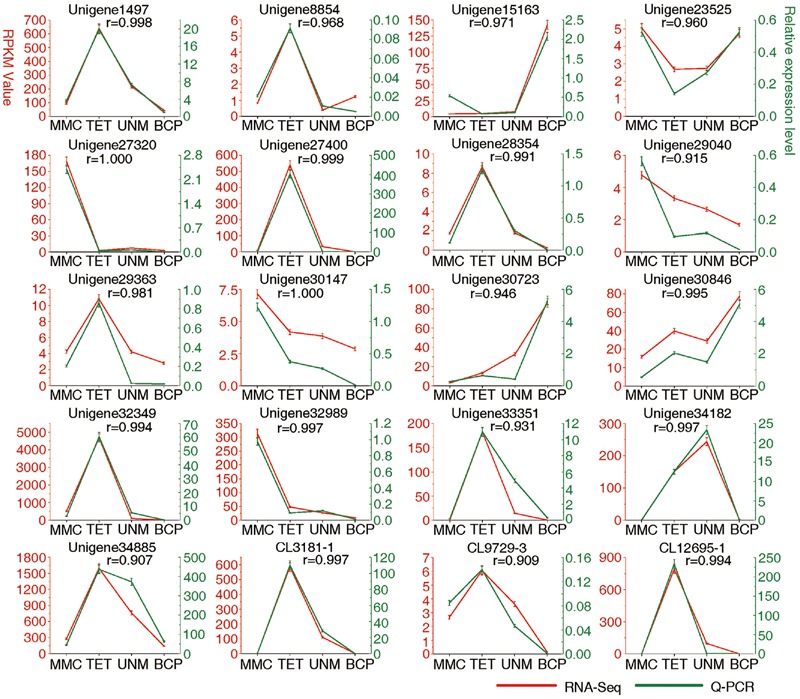
Result of q-PCR analysis. The left Y axis represents RPKM value of each gene using RNA-Seq analysis. The right Y axis represents log2 transformed relative transcript amount obtained by Q-PCR. The correlation co-efficient (r) between the two expression profiles is also showed.